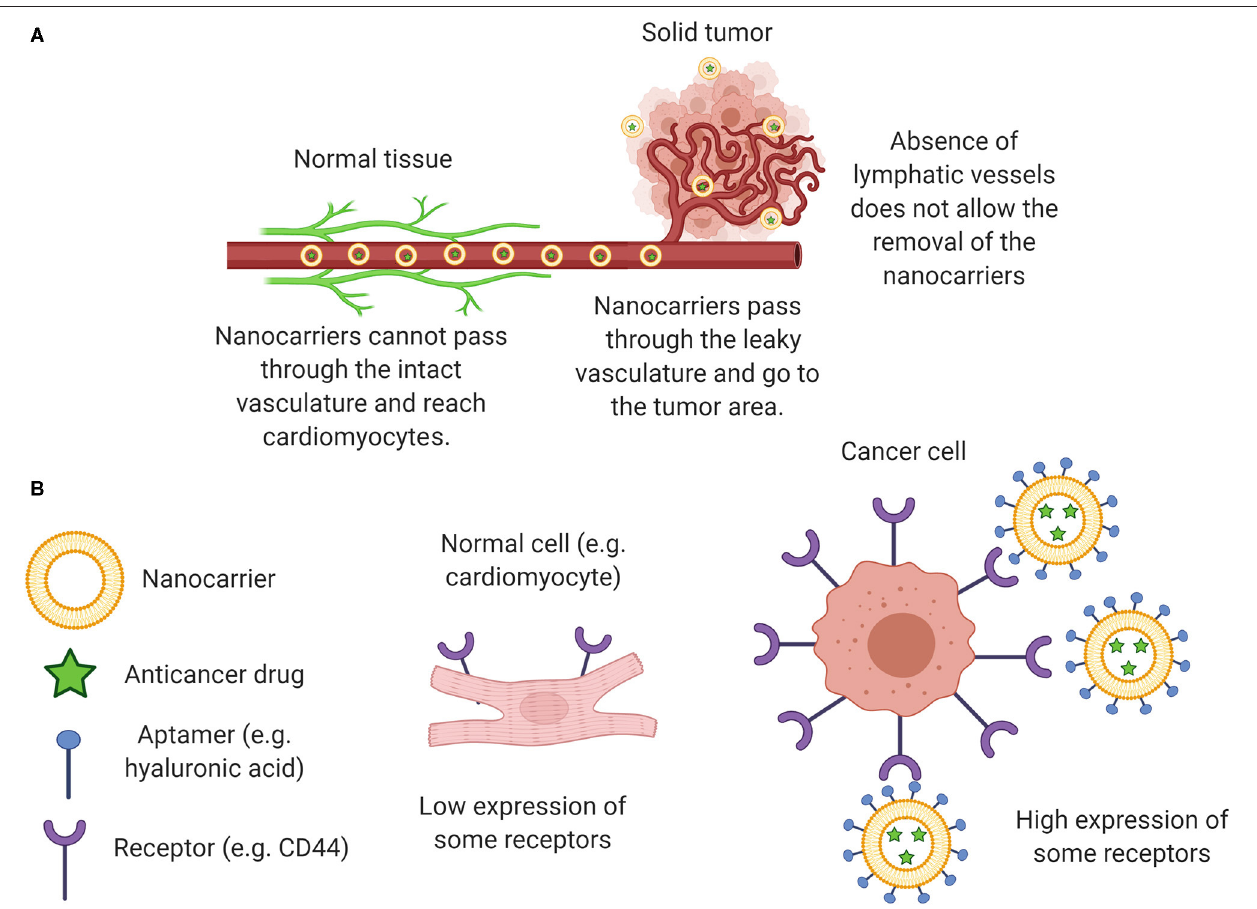
FIGURE 1 | (A) Representation of the EPR effect with the nanocarriers accumulating within the solid tumor and not within the cardiomyocytes; (B) Nanocarriers with active targeting, favoring the specificity for cancer cells instead of cardiomyocytes. EPR effect, enhanced permeability and retention